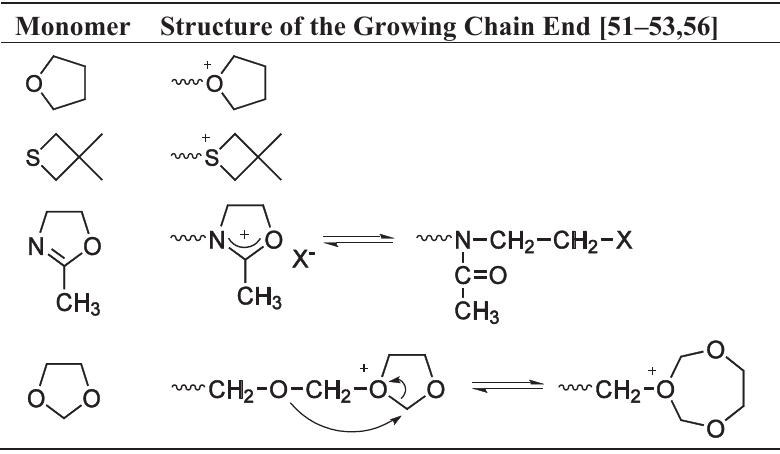
Table 2. The structure of the growing chain ends during CROP for a variety of monomers.